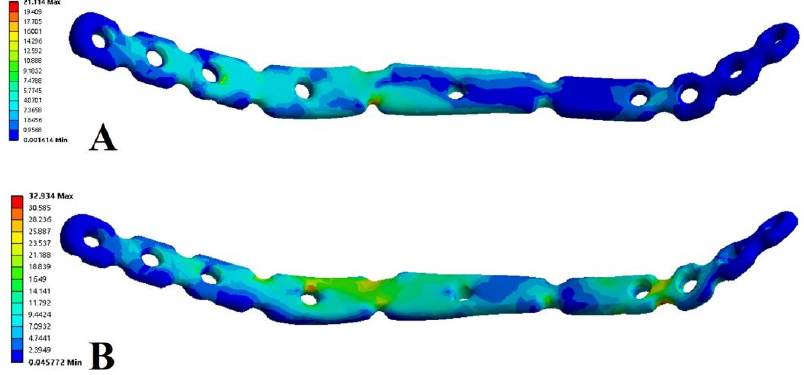
Figure 6. Von Mises stress distribution of implant during fixed with anterior ring plate. ( A ) Standing position. ( B ) Sitting position.